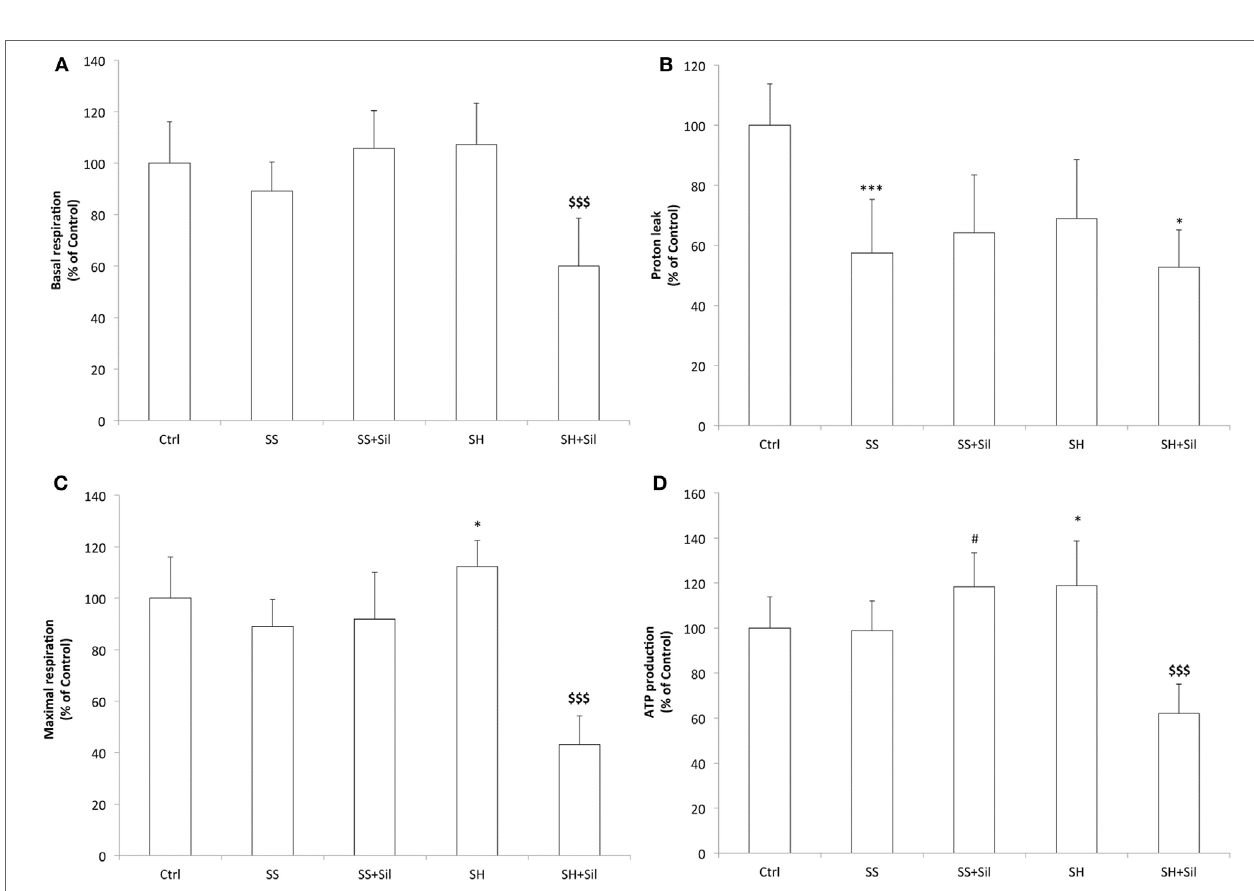
FigUre 4 | Effect of silybin on mitochondrial oxygen consumption rates (OCRs). Under the conditions of Figure 1 , we measured the cellular OCR by using Seahorse XFe96 Extracellular Flux Analyzer. The following respiratory parameters were evaluated: (a) Cell basal respiration (OCR pmol/min/SRB labeling). (b) Proton leak (OCR pmol/min/SRB labeling). (c) Cell maximal respiration (OCR pmol/min/SRB labeling); (D) ATP production (OCR pmol/min/SRB labeling). Data are expressed as mean ± SD of 14 separate experiments. ANOVA followed by Tukey’s test was used to assess the statistical significance between groups. Significant differences are denoted by symbols: Ctrl vs all treatments *** p ≤ 0.001, * p ≤ 0.05; SS vs all treatments, # p ≤ 0.05; SH vs all treatments $$$ p ≤ 0.001.